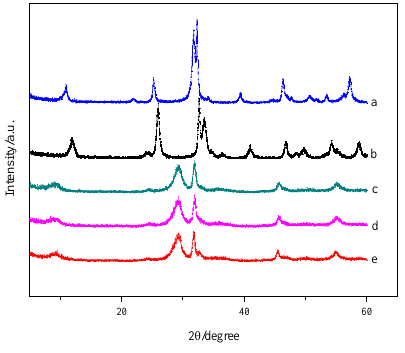
Figure 1. X-ray diffraction (XRD) patterns of ( a ) BiOBr, ( b ) BiOCl, ( c ) BiOI/BiOBr, ( d ) BiOCI/BiOl, and ( e ) BiOI.